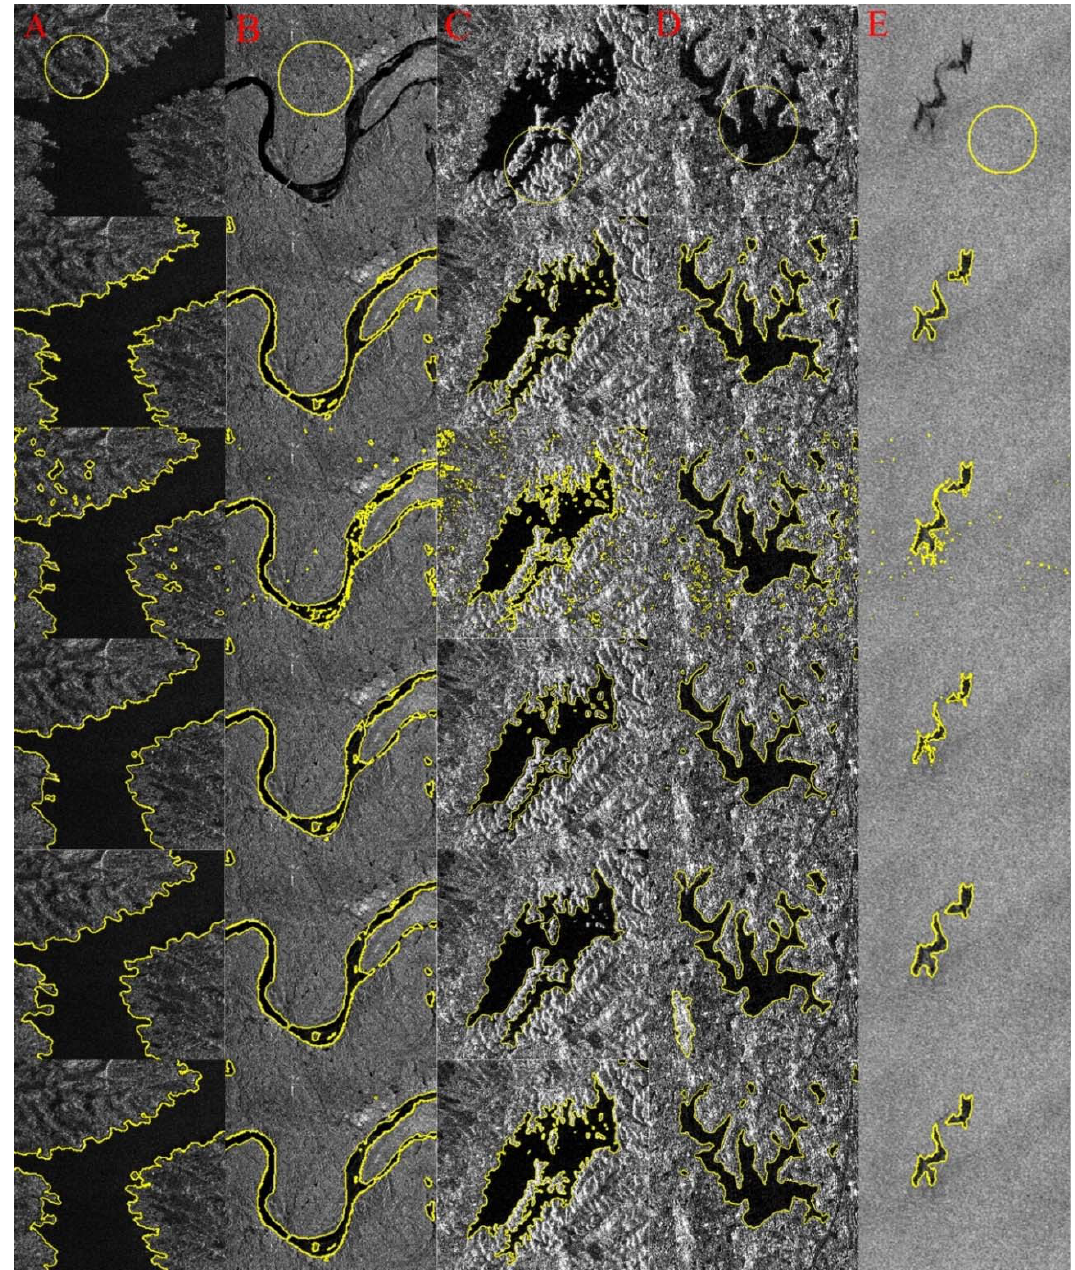
Figure 8. Segmentation of real SAR images. From first row to last row: original SAR images and different initial contours, the ground truth, the segmentation results of METHOD1, METHOD2, METHOD3 and our method, respectively.